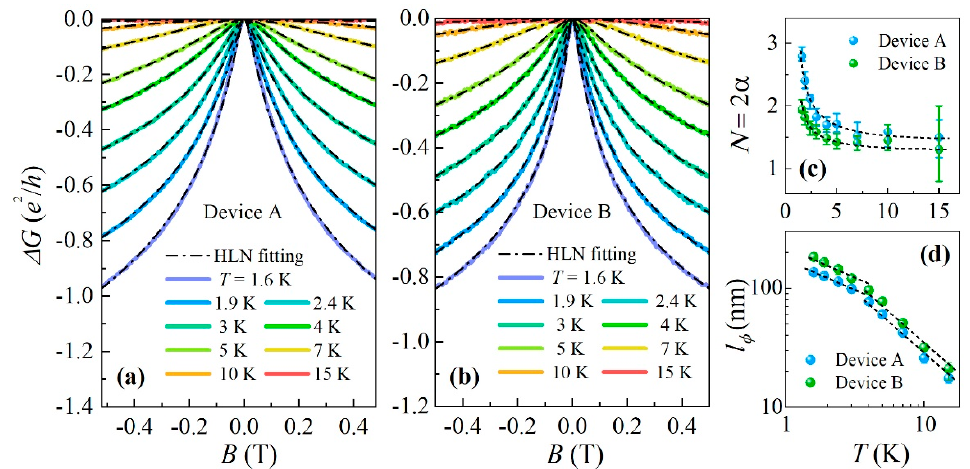
Figure 4. ( a , b ) Magnetoconductance ∆ G ( B ) = G ( B ) − G ( 0 ) measured at various temperatures between T = 1.6 K and 23 K. The dashed–dotted lines are curves fitted using the HLN equation. ( c ) Temperature dependence of N , obtained by HLN fitting. The error bars indicate the parameter range within which the deviation between the data and the fitted curves are acceptable. The dashed lines are a guide to the eye. ( d ) Temperature dependence of l φ , obtained by HLN fitting. The dashed reference lines correspond to l φ ∼ T − 0.5 ( T < 4 K ) and l φ ∼ T − 1 ( T ≥ 4 K )